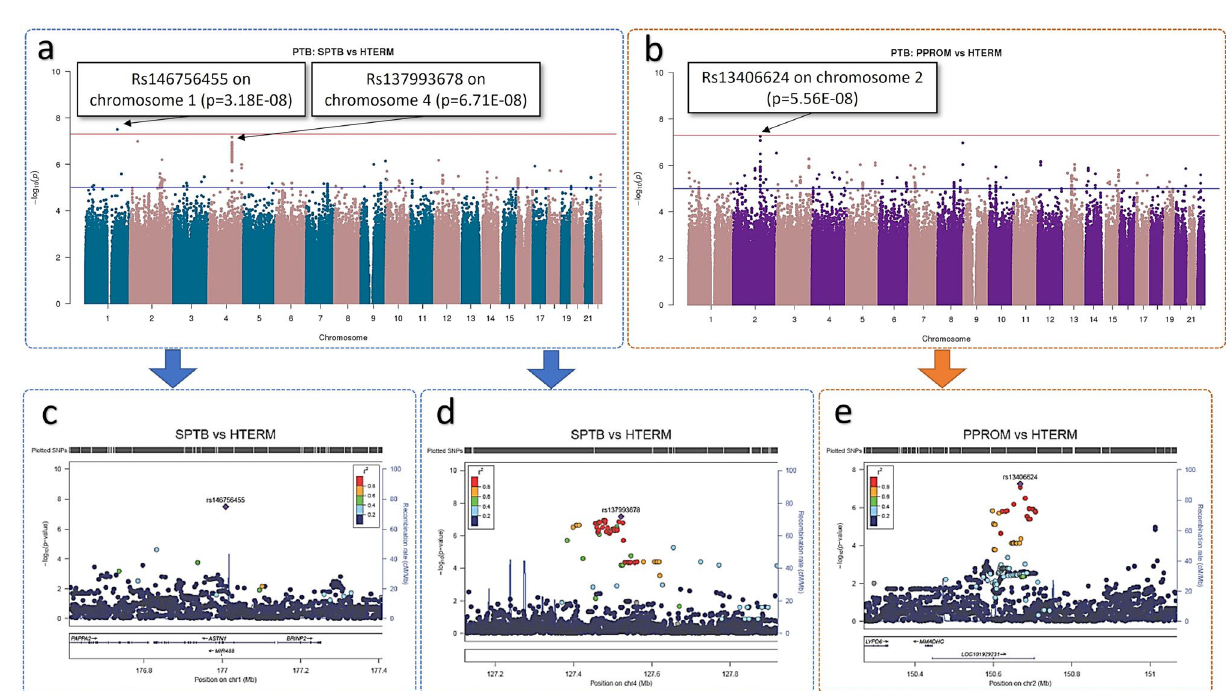
Figure 2. Genome-wide significant SNP identified from PPROM cases and LTERM controls GWAS analysis. ( a ) Manhattan plot of PPROM (n = 25) ≤ 34 weeks gestation and LTERM (n = 160) ≥ 39 weeks gestation GWAS analysis using Frequentist association test. Multi-dimensional scaling components 1 to 6 of the cohort were included as covariates. The upper red horizontal line displays the genome-wide significance threshold (p < 5 × 10 –8 ) and the lower blue horizontal line represents an arbitrary suggestive threshold (p < 1 × 10 –5 ). One SNP (rs187066376) exceeded genome-wide significance in this analysis on chromosome 4 (p = 5.71E−09). Figure generated using R package ‘qqman’ 28 . ( b ) Regional plot of rs187066376 signal. Two SNPs are shown in linkage disequilibrium in red and blue. Figure produced using LocusZoom 29 .